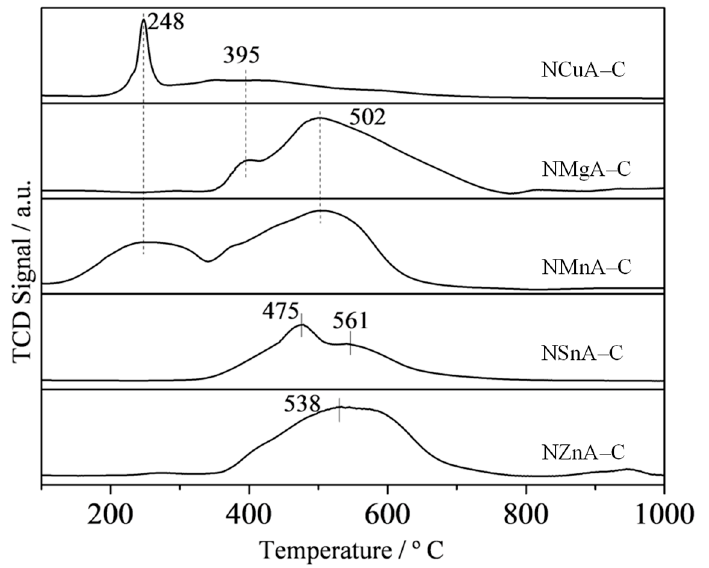
Figure 4. Temperature-programmed reduction (TPR) profiles of different calcined catalysts derived from hydrotalcite.